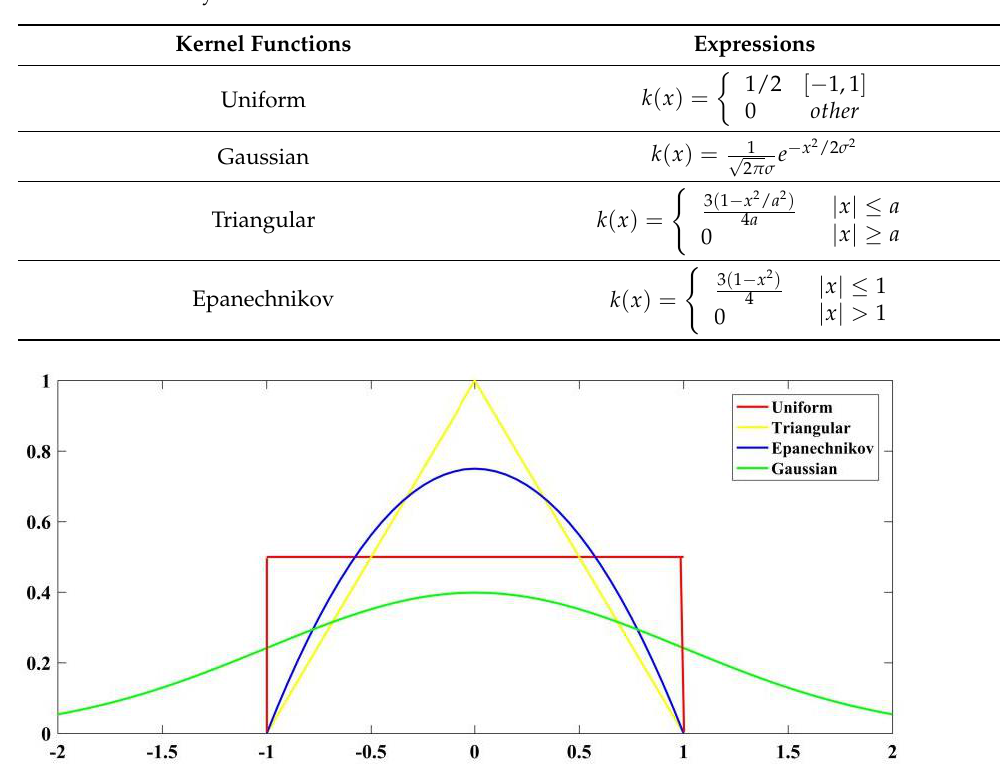
Table 3. Commonly used kernel functions.